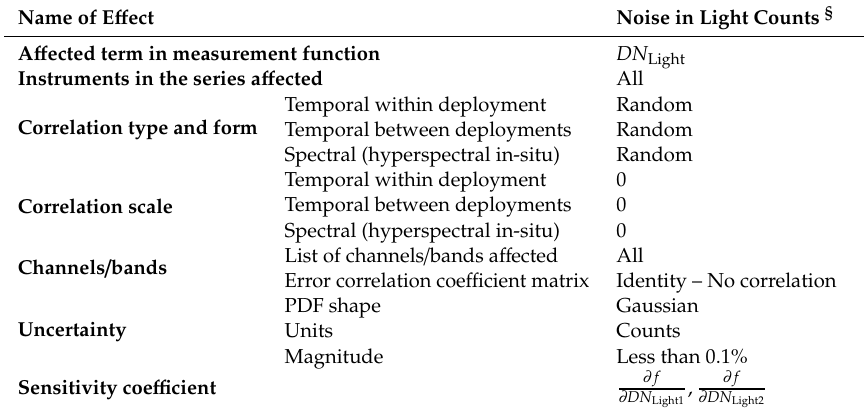
Table A2. E ff ects table for detector noise.